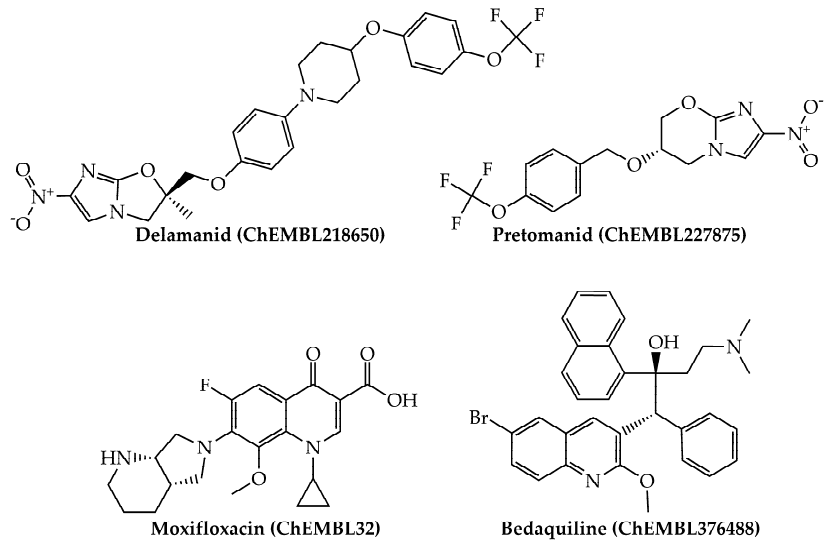
Figure 2. Other anti-TB drugs (nitroimidazopyrans, fluoroquinolones, and diarylquinolines)